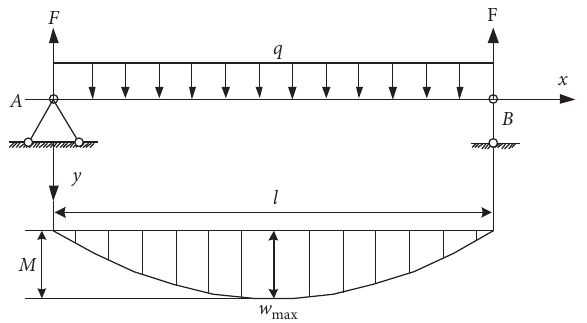
Figure 3: Mechanics model of simply supported beam in the LODM.